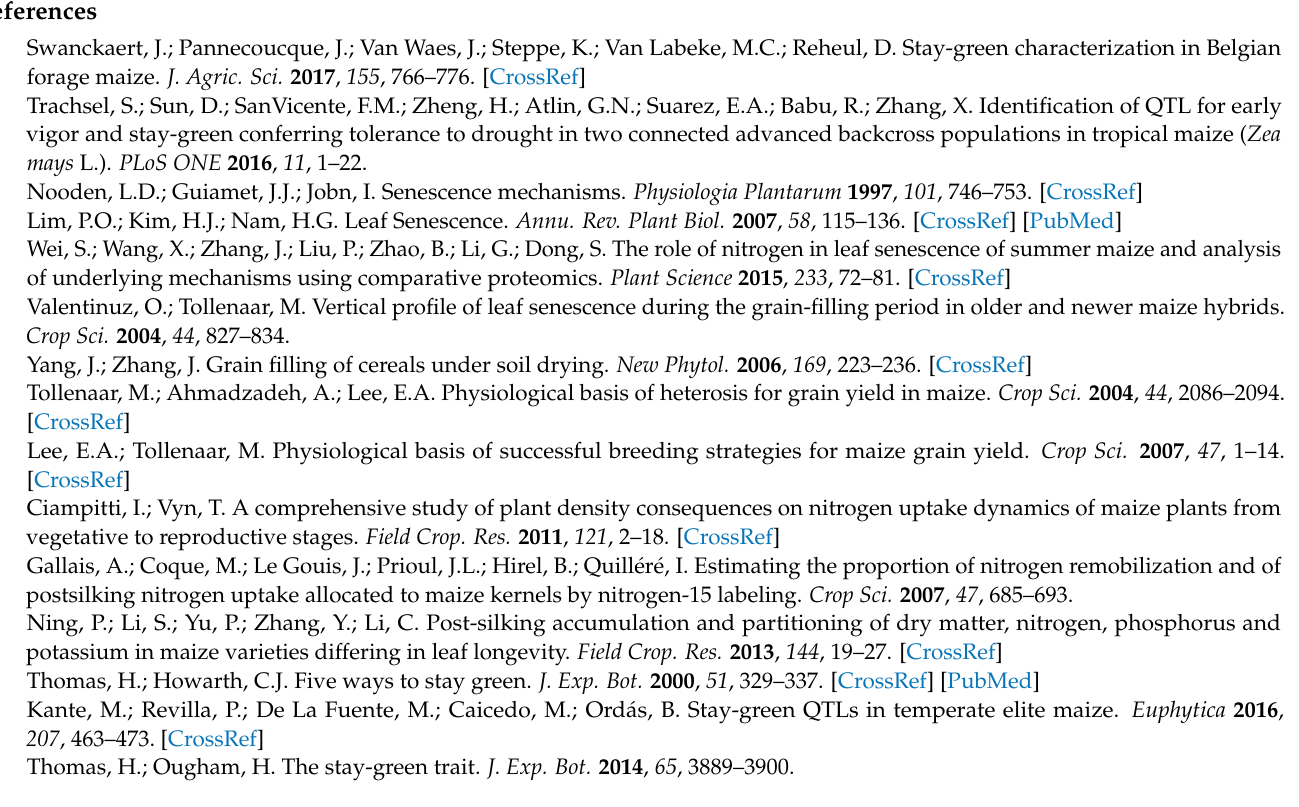
lines since flowering time, evaluated in 2017 in Xinzo location (Spain). Mean ± stderrare presented. Table S5: Means, standard errors, and comparison between SG and NSG for stover production of maize inbred lines, with contrasting Stay-green phenotype evaluated in 2017 in Tomeza location (Spain). Table S6: Means, Standard errors, and comparison between SG and NSG for agronomic characters of maize inbred lines with contrasting stay-green phenotype evaluated in 2017 in two locations in Tomeza location (Spain). Table S7: Means, Standard errors, and comparison between SG and NSG for stover production of maize inbred lines, with contrasting Stay-green phenotype evaluated in 2017 in Xinzo location (Spain). Table S8: Means, Standard errors, and comparison between SG and NSG for agronomic characters of maize inbred lines with contrasting stay-green phenotype evaluated in 2017 in two locations in Xinzo location (Spain). Table S9: Total N content at silking time and physiological maturity of plant stover (leaf and stem), N-content in grain of maize inbred lines, evaluated in 2017 in Tomeza and Xinzo